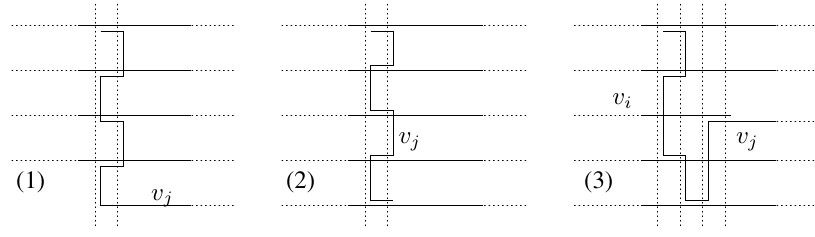
Fig. 8: The grid path for vertex v j in the three cases of a graph of pathwidth k . Only grid paths of earlier neighbours of v j are